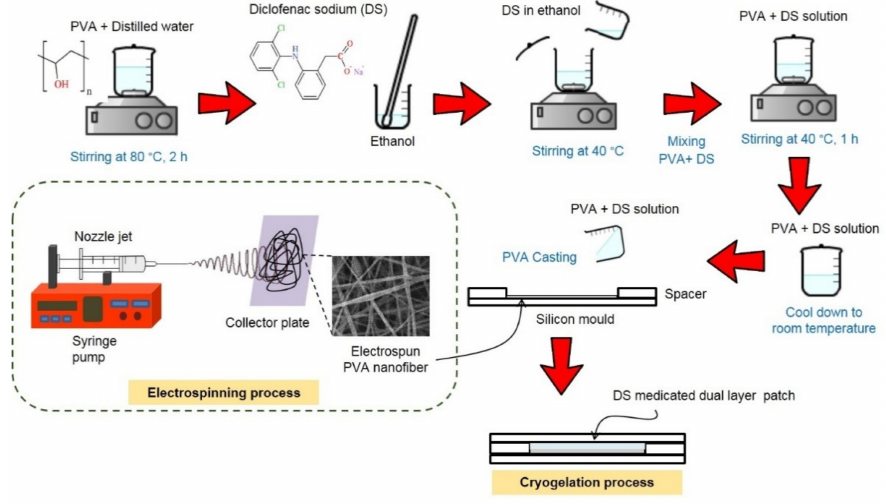
Figure 2. Preparation process of DS-medicated dual layer PVA patches.